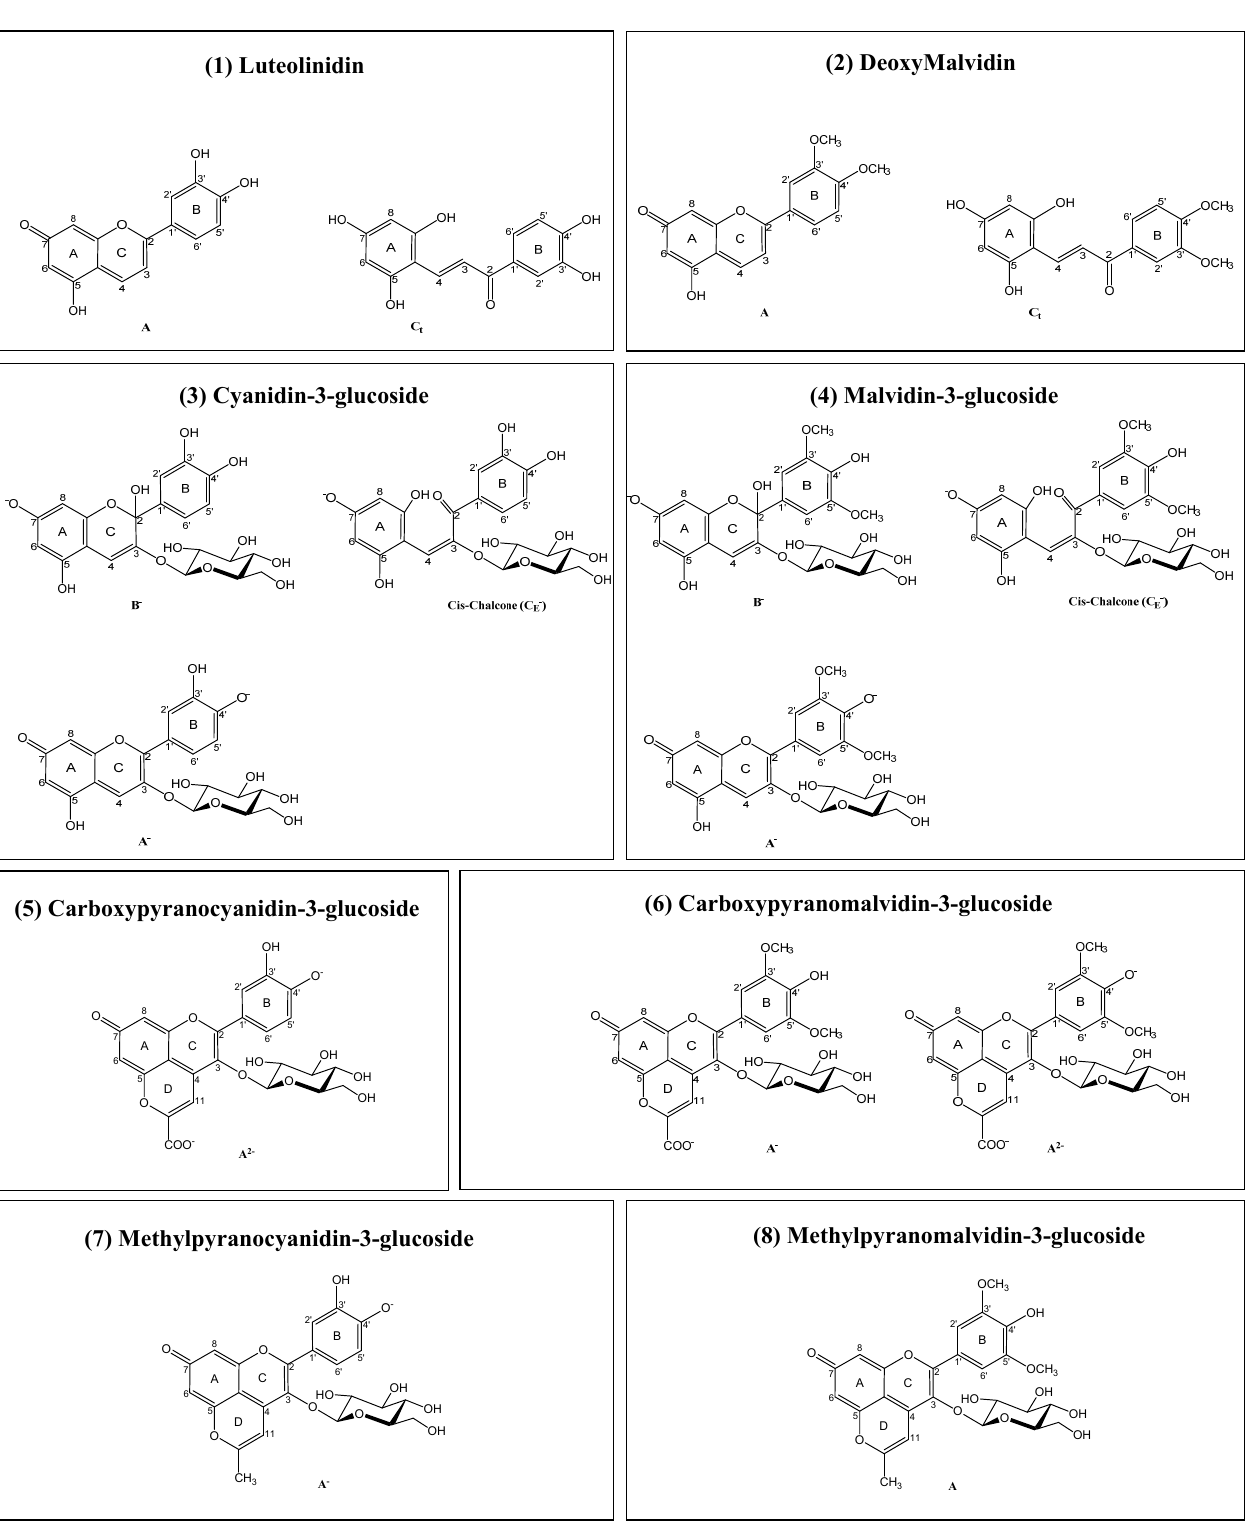
Figure 1. Chemical structures of the main equilibrium forms of the selected group of anthocyanins, deoxyanthocyanins, and pyranoanthocyanins present at pH 7.4. A, quinoidal form; B, hydrated form; C c , chalcone cis isomer; C t , chalcone trans isomer; and C E , chalcone E isomer.